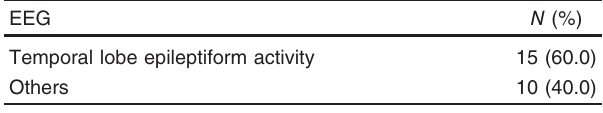
Table 4 Distribution of studied sample (focal epilepsy only) according to electroencephalography